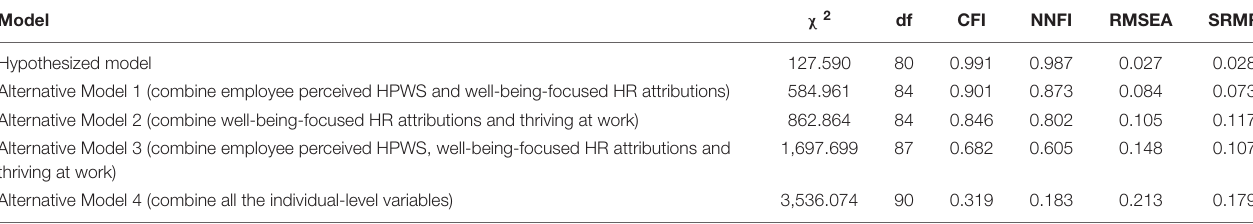
TABLE 2 | Results of confirmatory factor analyses.